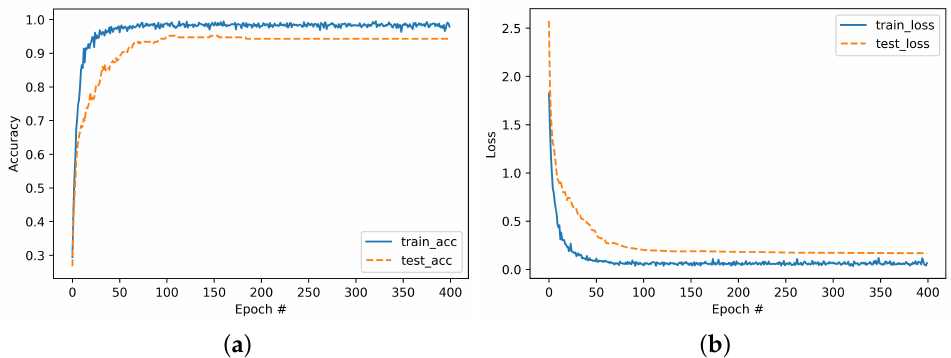
Figure 11. MobileNet-V2 training accuracy and loss ( a , b ).